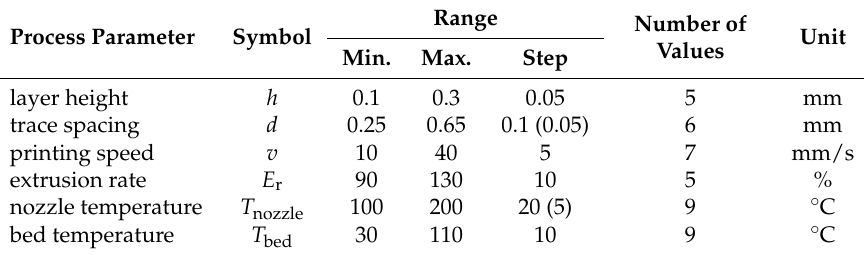
Table 1. Determined ranges for defined process